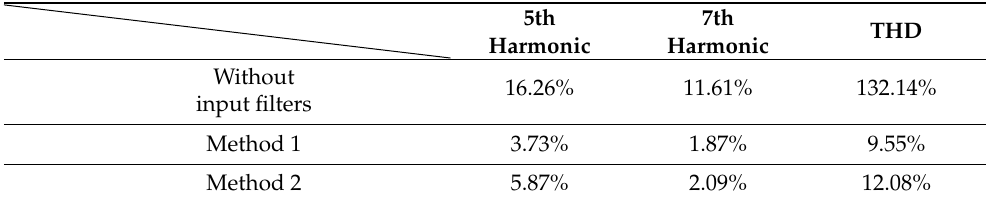
Figure 13. Measured current responses. ( a ) PI current controller, ( b ) predictive current controller. Table 2. Comparison of input harmonic currents.